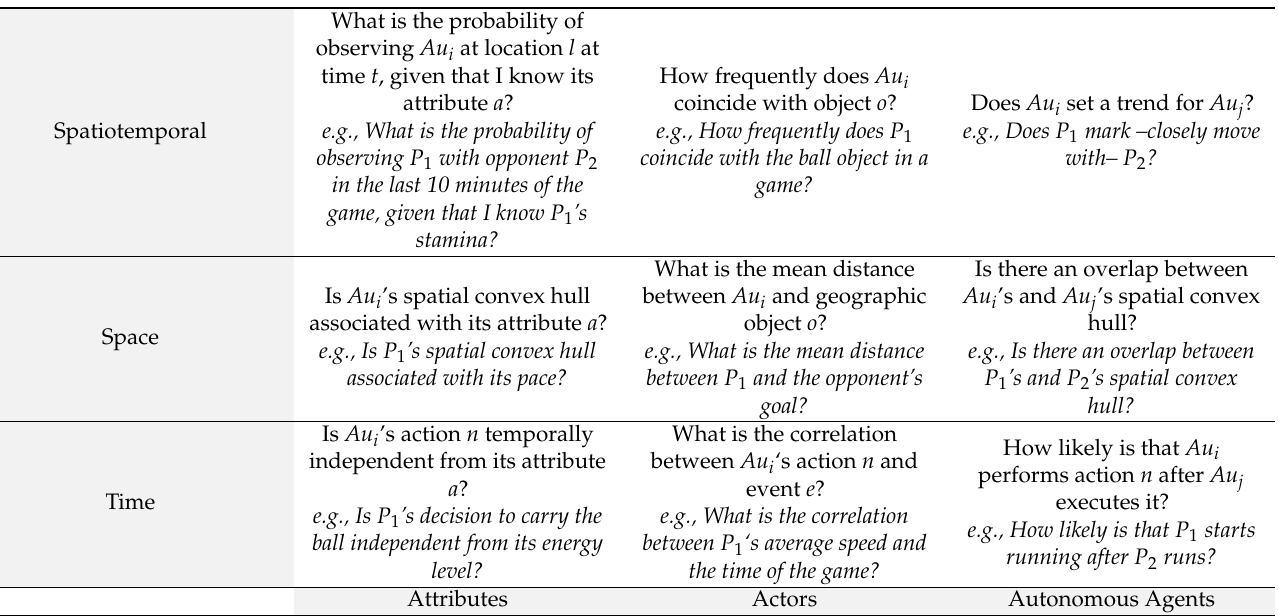
Table 1. Some typical association and what questions that can be answered by an observer about the auto-agents Au i and Au j ( players P 1 and P 2 in the football example ).